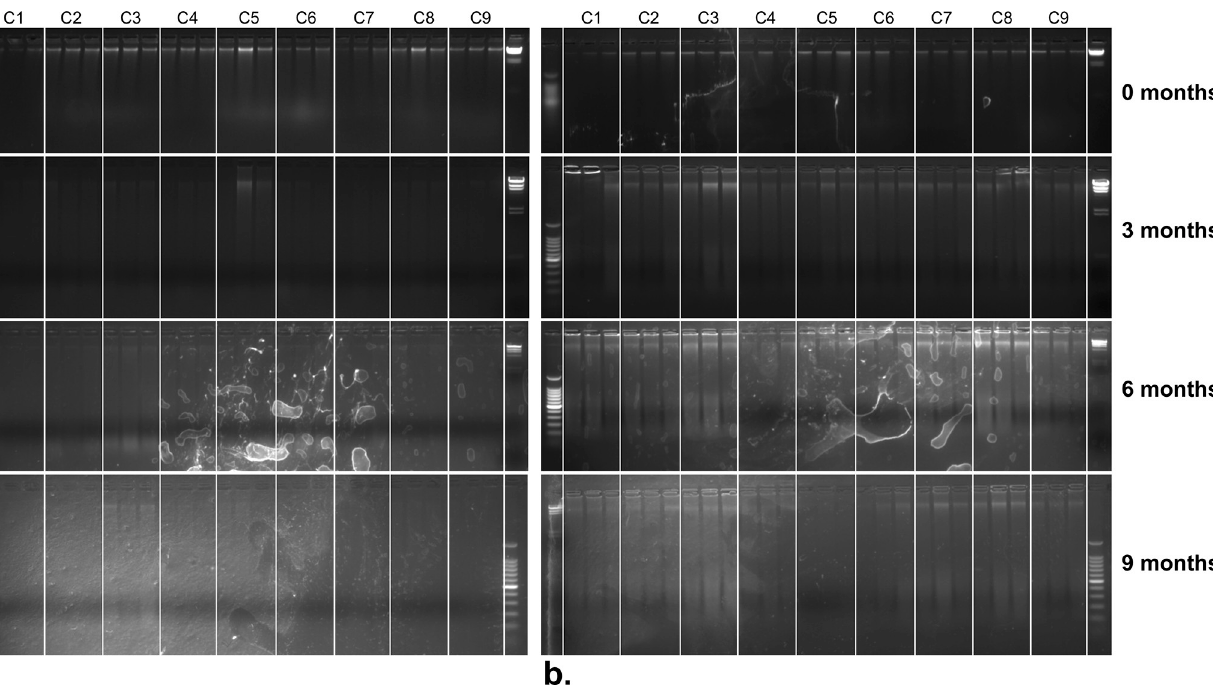
PLOS ONE | https://doi.org/10.1371/journal.pone.0211743 January 31,